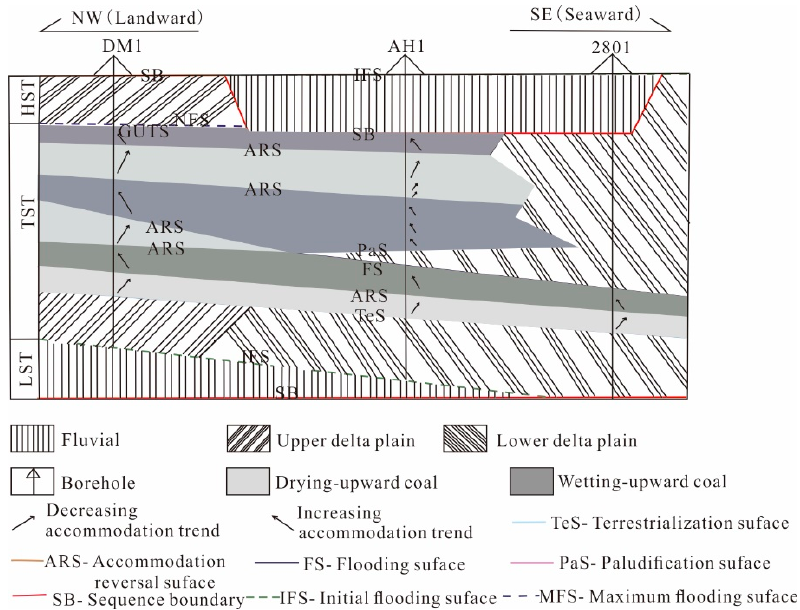
Figure 16. A sequence stratigraphic model of the No. 2 1 coal member from the Anhe Coalfield (modified from [71]). LST, low-stand systems tracts; TST, transgressive systems tracts; HST, high-stand system tracts.